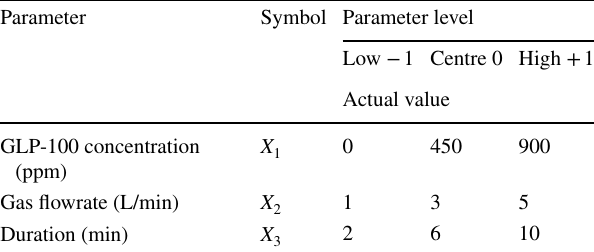
Table 2 Parameters and the actual values